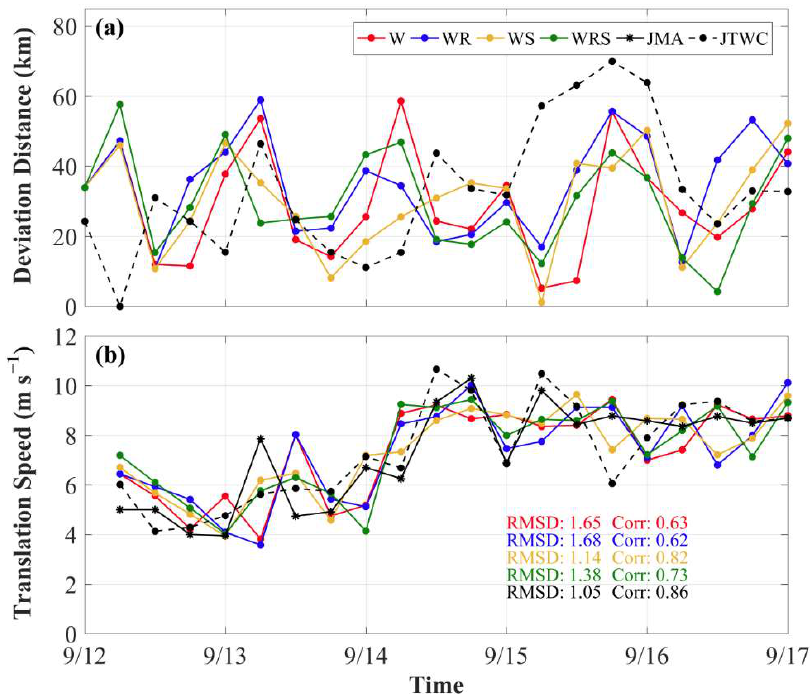
Figure 3. Quantification of typhoon track simulation. ( a ) Track deviation distance from JMA data (km); and ( b ) translation speed of Typhoon Kalmaegi (m s −1 ). JMA (bold black line), JTWC (dashed black line), W (red), WR (blue), WS (orange) and WRS (green). The same colors are used for RMSD and R 2 , which are calculated relative to JMA data. The dots represent data between 00:00 12 September and 00:00 17 September, with 6-h intervals.